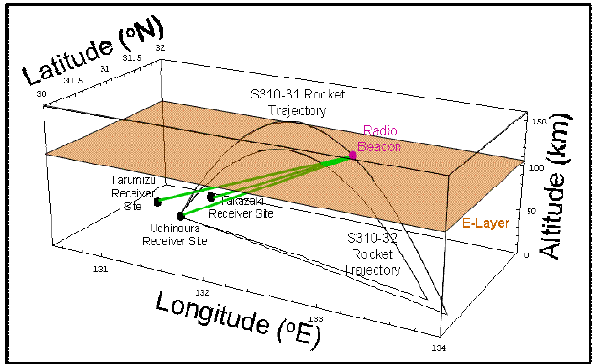
Figure 2. Three-dimensional projection of the SEEK2 rocket transmitting to ground receivers. Fig. 2. Three-dimensional projection of the SEEK-2 rocket trans- mitting to ground receivers.